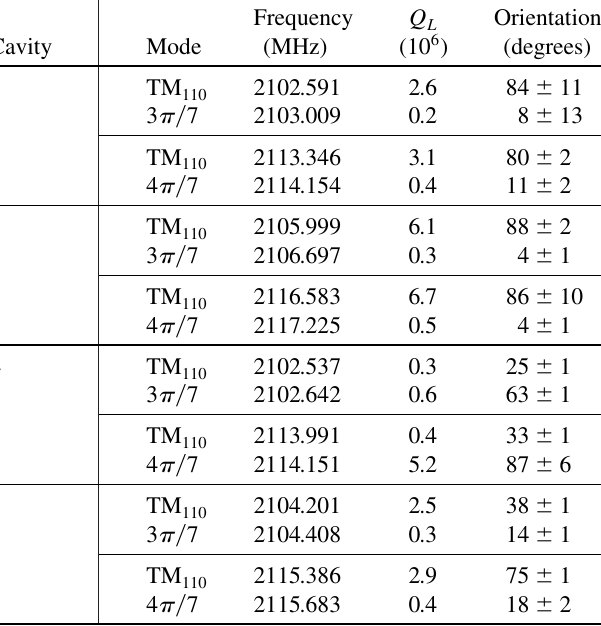
mode was oriented L